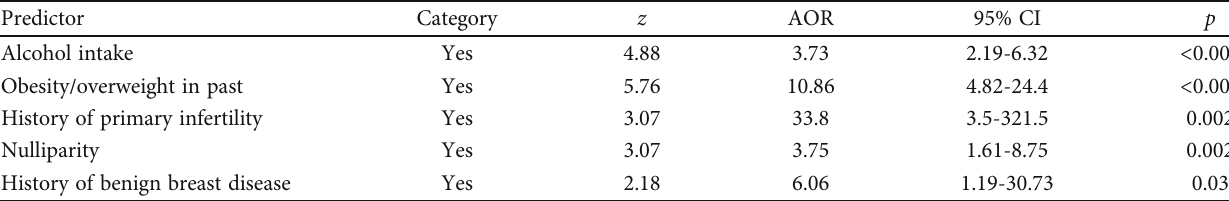
Table 3: Predictors of breast cancer in premenopausal